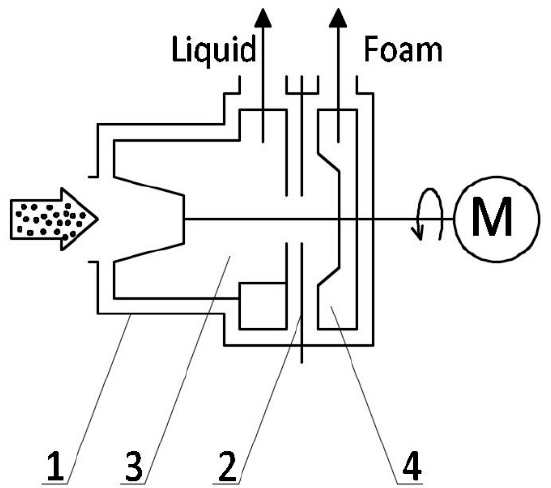
Figure 1. Schematic diagram of the skimming pump: 1—casing; 2—baffle plate; 3—liquid pumping rotor; 4—foam breaking rotor.